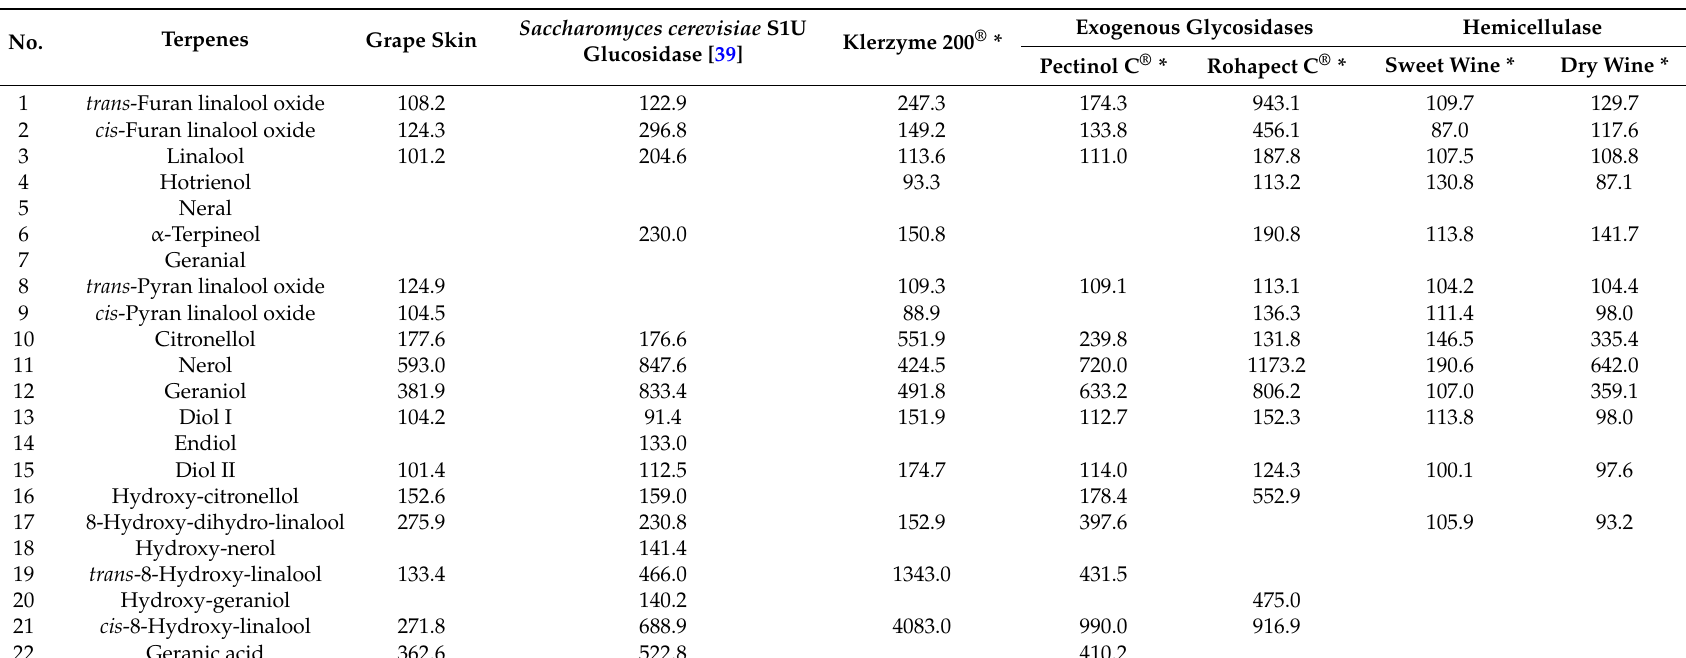
Table 1. Results obtained by hydrolysis of terpene glycosides treated with different enzymatic preparations (200 µ L of each commercial preparation). Data are normalized to 100 in untreated